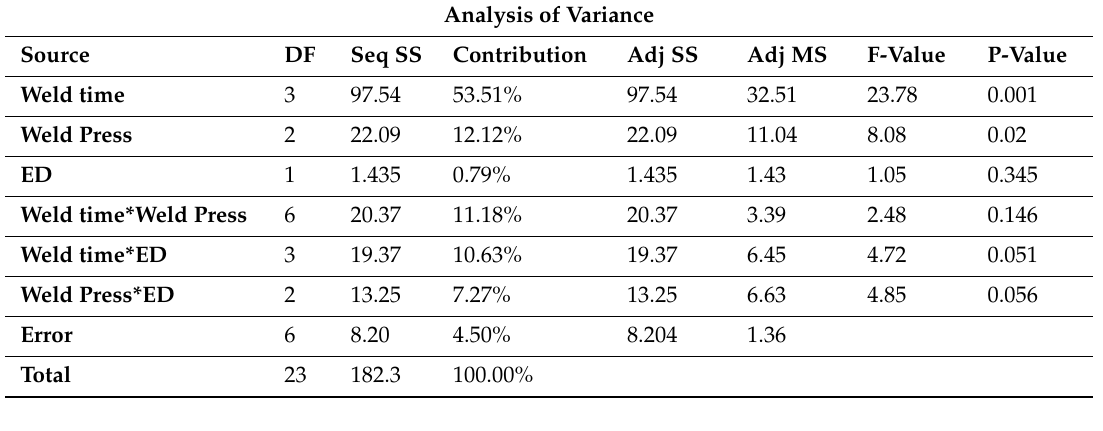
Table A1. ANOVA analysis for integrated ED (SC-ELC_FL-ELC and 2SC-ELC_SC-ELC). Table A.1: ANOVA analysis for integrated ED (SC-ELC_FL-ELC and 2SC-ELC_SC-ELC) Analysis of Variance